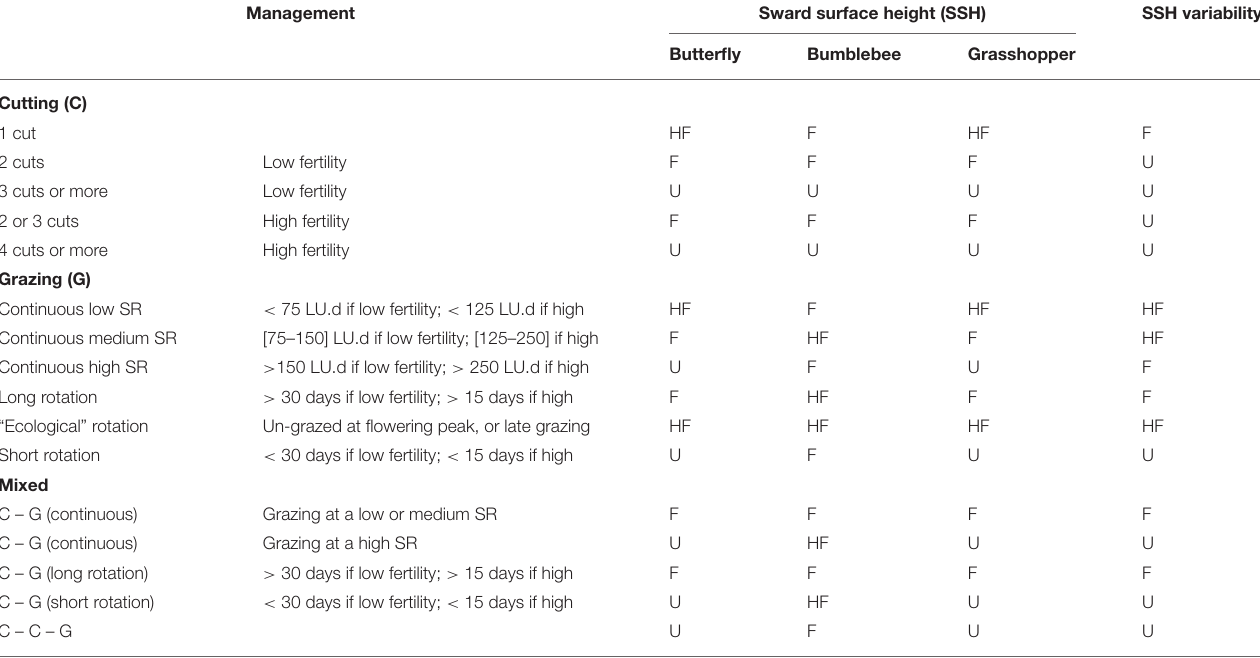
TABLE 1 | Effect of management practices on the suitability of grassland types as habitat for butterflies, bumblebees, and grasshoppers, via the effects of management on sward structure (i.e., sward surface height and variability).